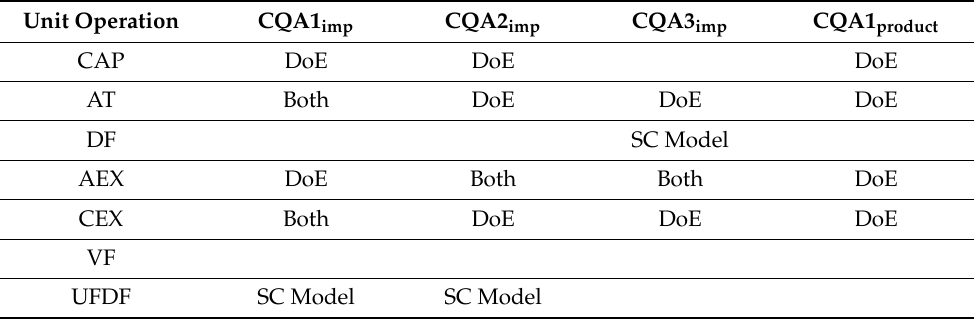
Table 1. Summary of models used for Monte Carlo simulation. DoE models are multiple linear regression models from statistically underpinned designs. SC models are single-factor linear regres- sion models of load to specific clearance. If both types of model were available, ‘Both’ is marked in the